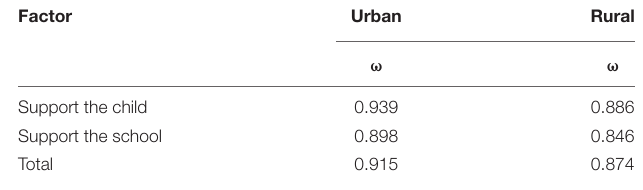
TABLE 7 | Coefficient omega for the factors